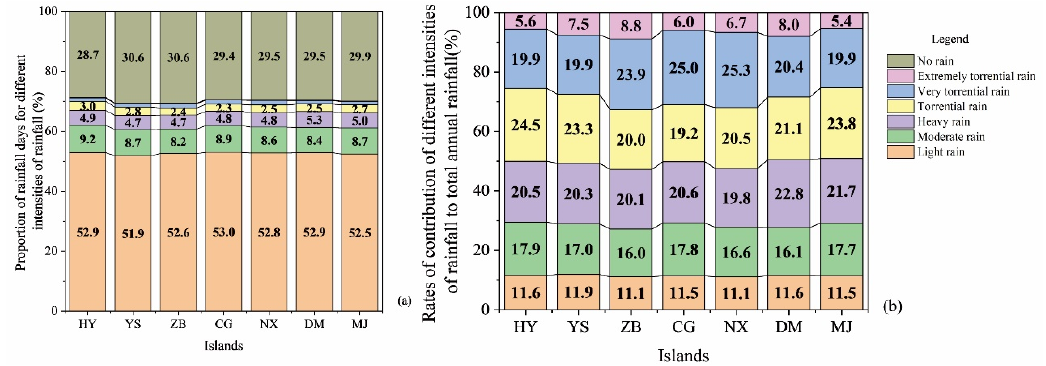
Figure 4. ( a ) Proportion of rainfall days by rainfall intensity; ( b ) rates of contribution of different intensities of rainfall to total annual rainfall.